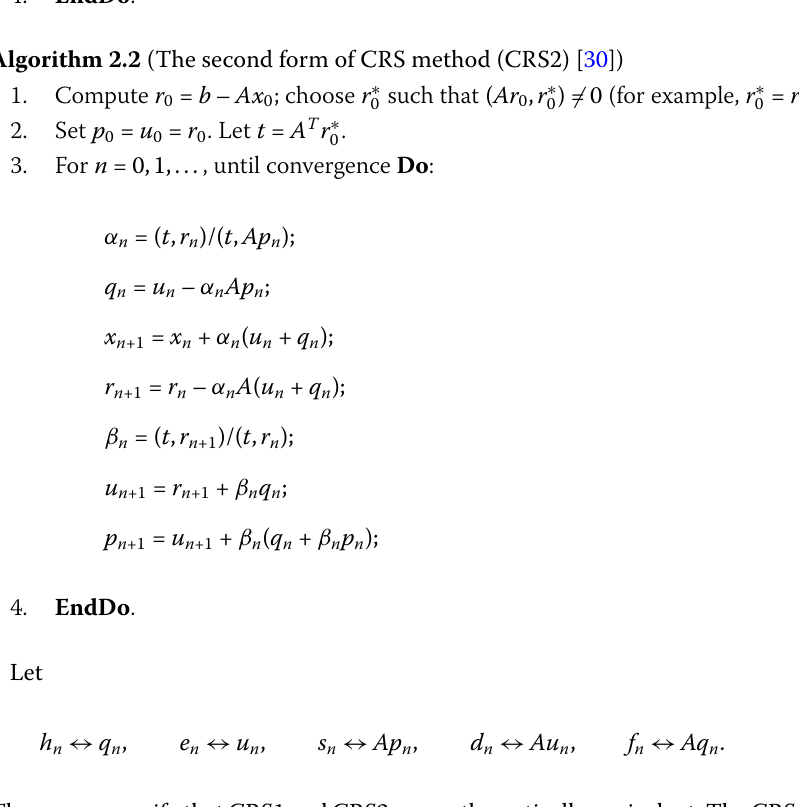
Algorithm 2.2 (The second form of CRS method (CRS2)